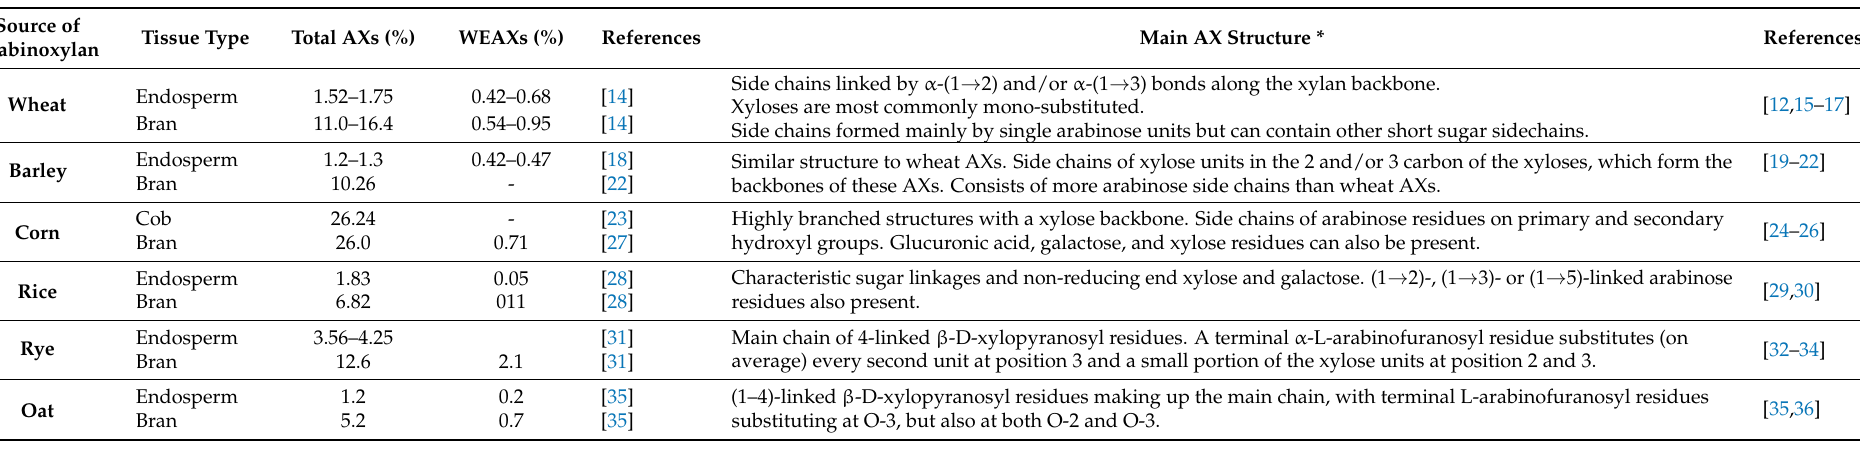
Table 1. Summary of the main structural characteristics of total AXs and water-extractable AXs (WEAXs) found in different cereal grains. Xylan backbone substitutions between each AX differs. However, similar chemical structures are apparent amongst them. * The minor changes in these structural characteristics result in different interactive behaviours with other